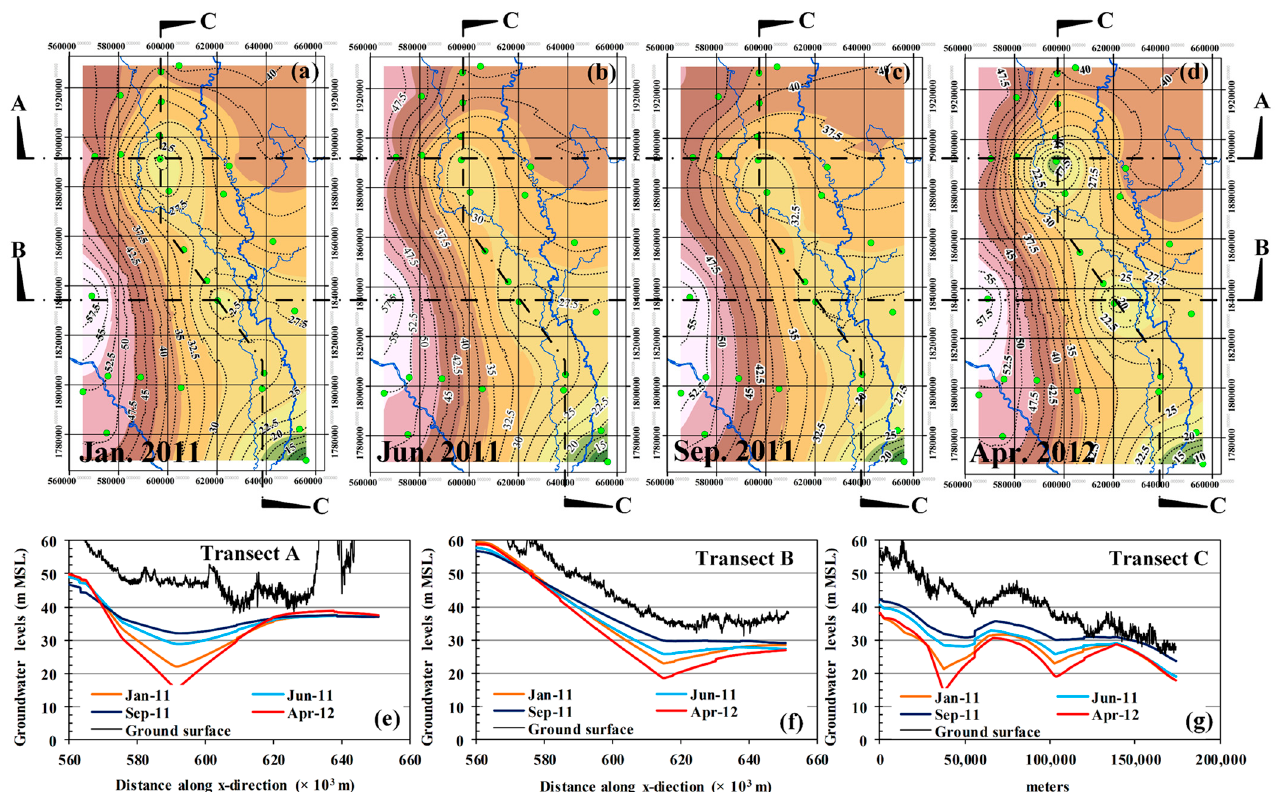
Figure 7. Temporal and spatial variability of groundwater levels in the UCP’s flood-prone area before and after the 2011 flood event.